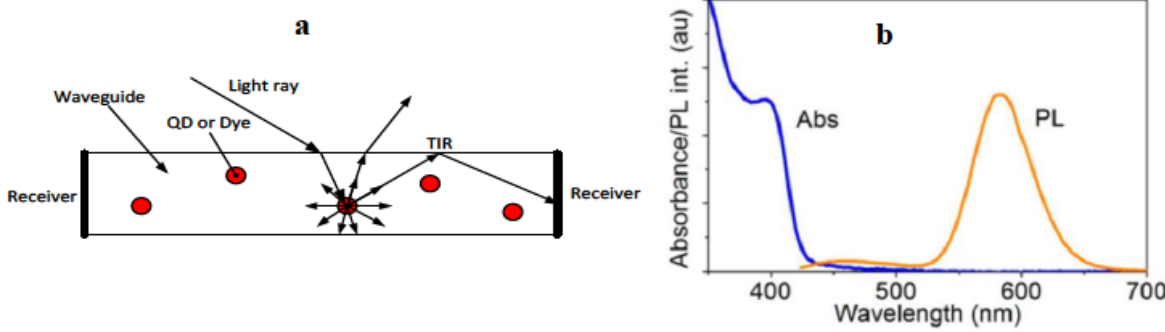
Figure 5: Spectral light management using a LSC: (a) Luminescent solar concentrator absorbing and then isotropically emitting down shifted photons within a waveguide. (b) Example of a very large Stokes shift using doped nanocrystals in an LSC